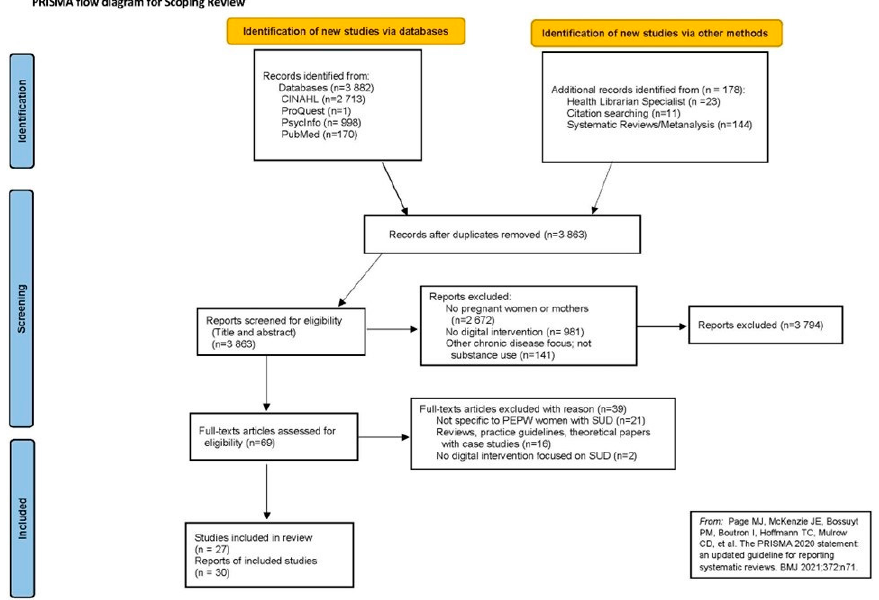
Figure 1. Prisma diagram for scoping review [23].